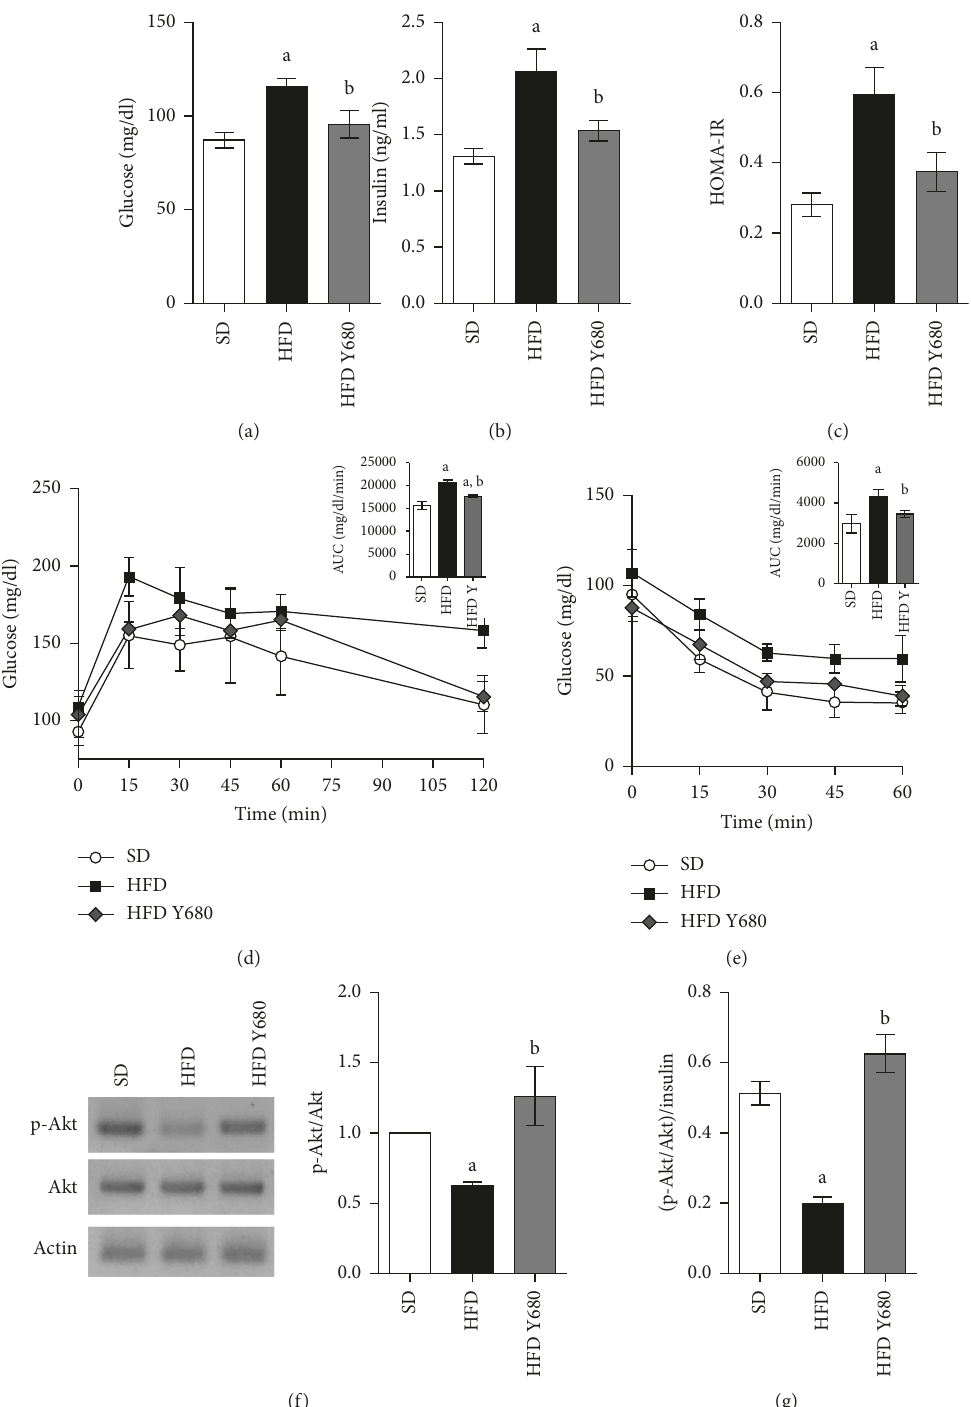
Figure 5: Effects of yacon flour on HFD-induced metabolic disease. (a) Fasting glucose concentrations at the end of experiment. (b) Time course of glycemia in response to oral glucose overload (2g/kg body weight) at 8 weeks (insert: area under the curve of blood glucose following glucose overload). (c) Time course of glycemia following a single intraperitoneal (i.p.) injection of insulin (0.75 U/kg b. w.) after 8 weeks of yacon supplementation (insert: area under the curve of blood glucose following insulin injection). (d) Fasting plasma insulin concentrations at the end of experiment. (e) Homeostasis model assessment of insulin resistance (HOMA-IR) index. (f) Akt and p-Akt protein expressions in visceral fat by western blotting. The mean value of SD-fed rats was set at 1. (g) p-Akt/Insulin ratio. Data are expressed as the mean standard deviation ( n 6/group). a p 0 . 05 vs. SD, b p 0 . 05 vs. HFD. SD: standard diet-fed rats; HFD: high-fat-diet-fed rats; (cid:31) HFD SD: high-fat-diet-fed rats reversed to a SD chow; HFD SY680: high-fat-diet-fed rats reversed to a SD chow and supplemented with yacon flour (680 mg FOS/kg b. ± < <